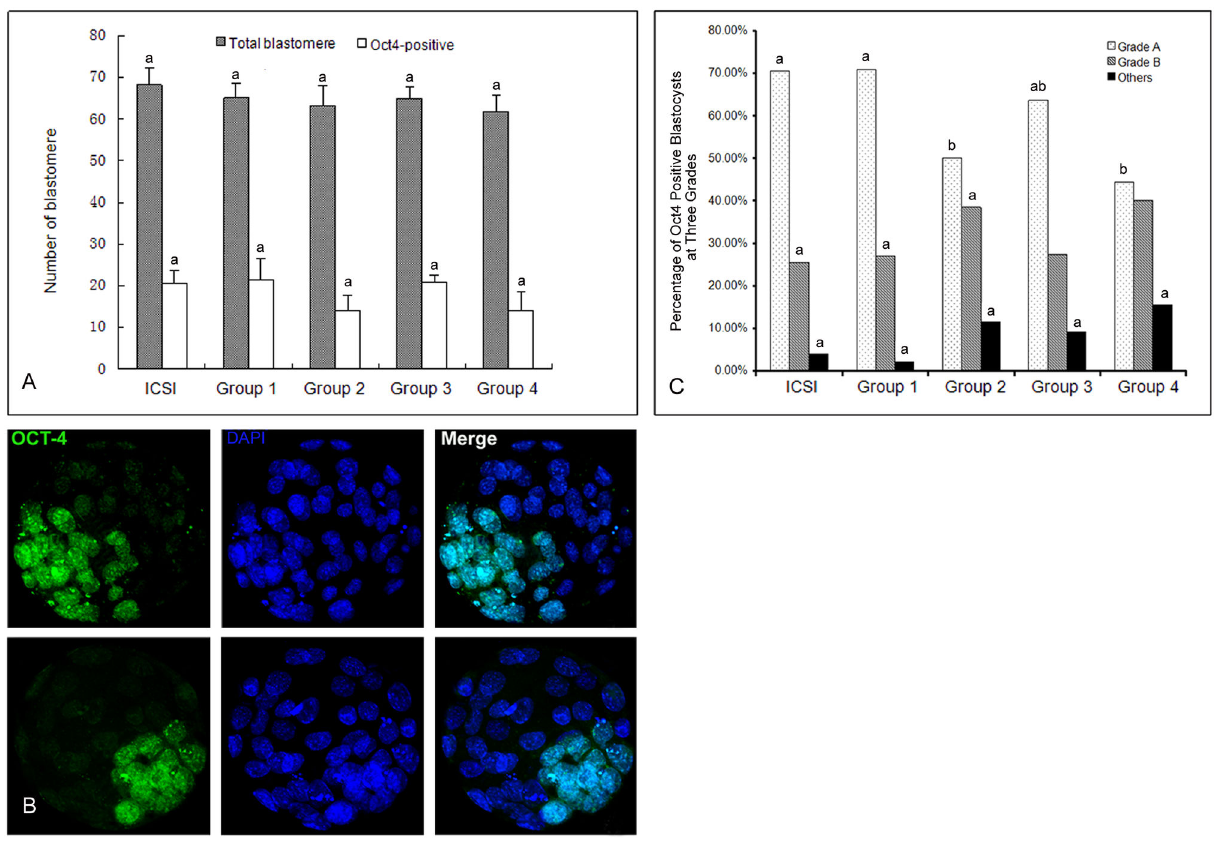
Figure 2. Oct4 expression in expanded blastocysts and the percentage of blastocysts expressing Oct4 . The total blastomeres and the blastomeres expressing Oct4 in expanded blastocysts from ICSI control and four ROSI groups; Bars represent means ± SD (A). Representative images of Oct4 expression in expanded mouse blastocysts derived from ROSI or ICSI (B); The upper panels show an example of a Grade A blastocyst with more than 15 Oct4-positive blastomeres, and the lower panels show an example of Grade B blastocysts with between eight and 15 Oct4-positive blastomeres. Oct4 expression is shown in green and DAPI-stained nuclei are shown in blue; Scale bar: 20 μm. The proportion of Grade A, Grade B and other blastocysts (less than 8 Oct4-positive blastomeres) are also shown for each experimental group and the ICSI control group (C). The values on the same color columns bearing different letter on top were significantly different at P < 0.05.